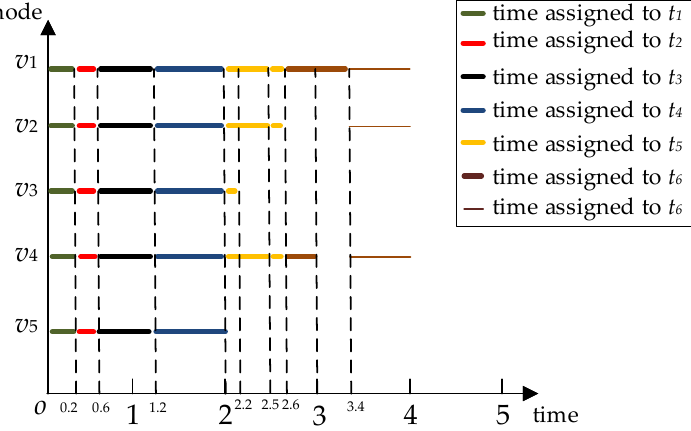
Figure 7. The specific task assignment of the EFTT